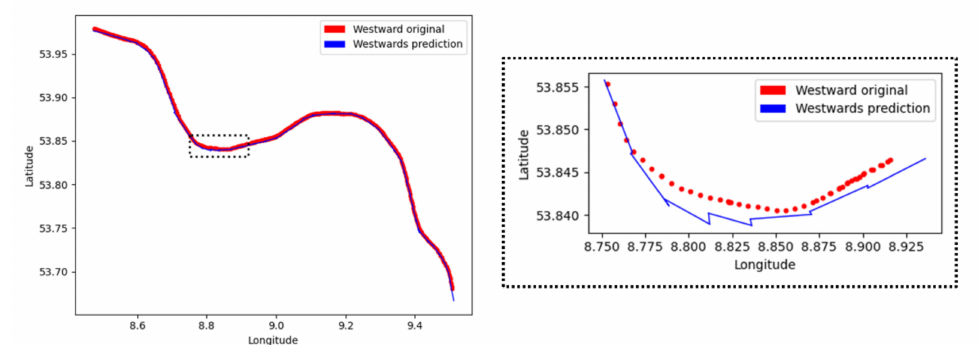
Figure 15. Predicted track (blue), using the expected value compared with the actual track (red) for a vessel sailing westward through the Elbe